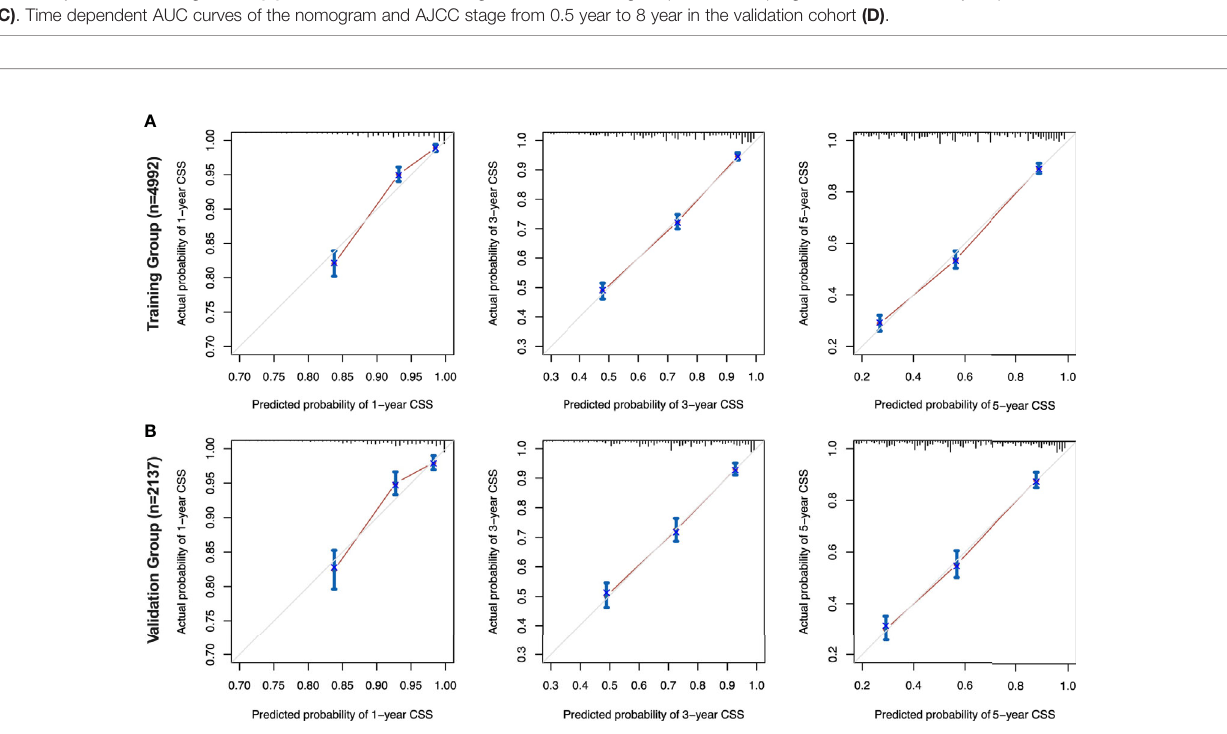
FIGURE 5 | Calibration curves for the nomogram in the training and validation cohorts. 1-, 3-, and 5-year calibration curves (A) for the CSS nomogram in the training cohort of patients with EOC (bootstrap = 1,000 repetitions). 1-, 3-, and 5-year calibration curves (B) for the CSS nomogram in the validation cohort of patients with EOC (bootstrap = 1,000 repetitions). EOC, epithelial ovarian cancer; CSS, cancer-speci fi c